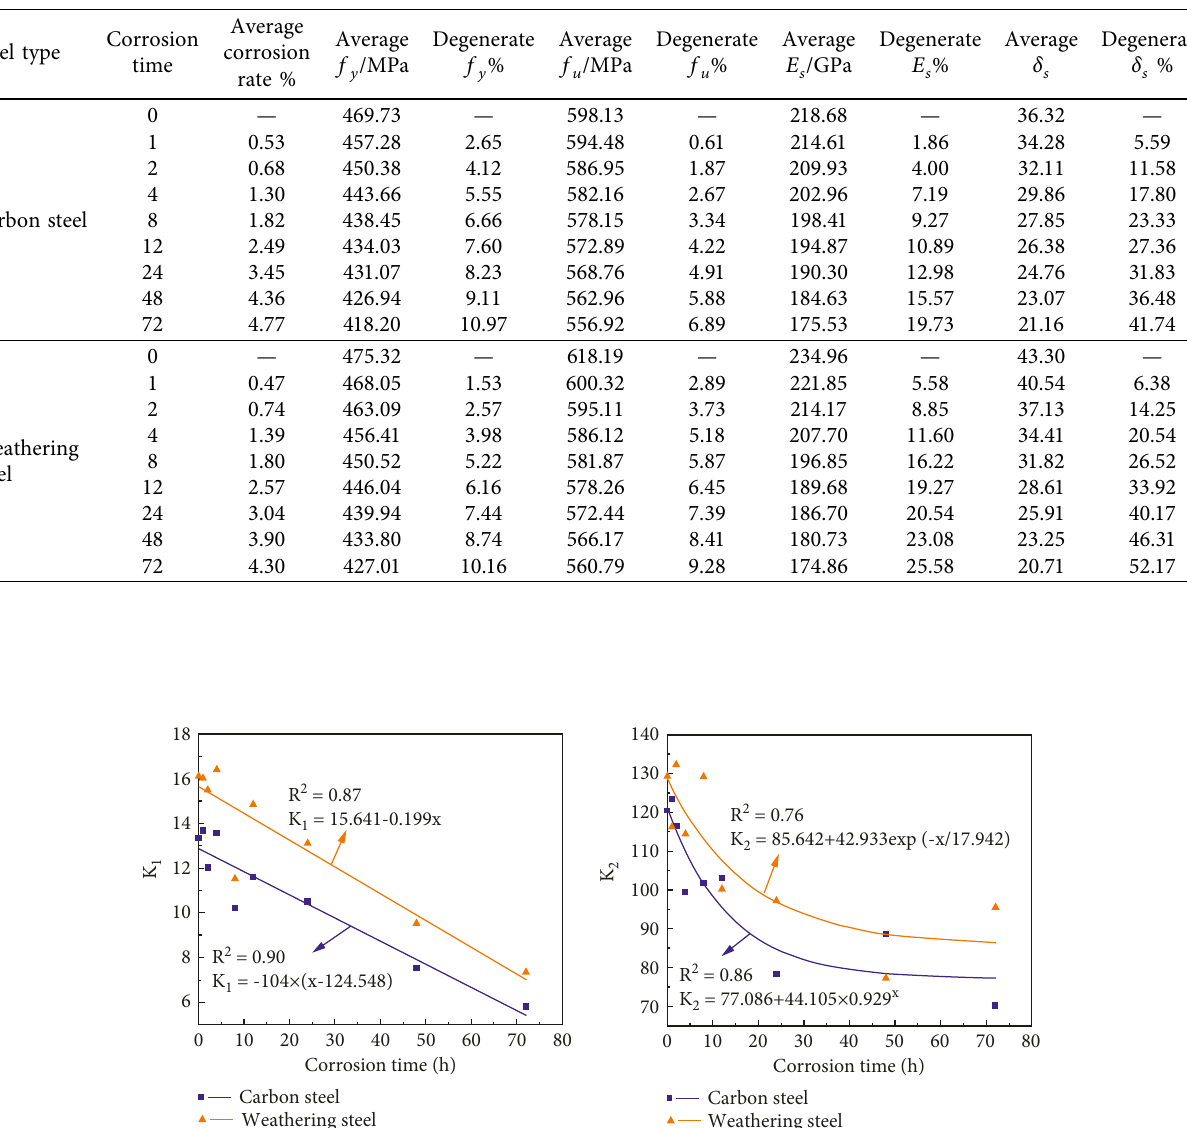
Table 2: Degradation of mechanical indexes of steels.